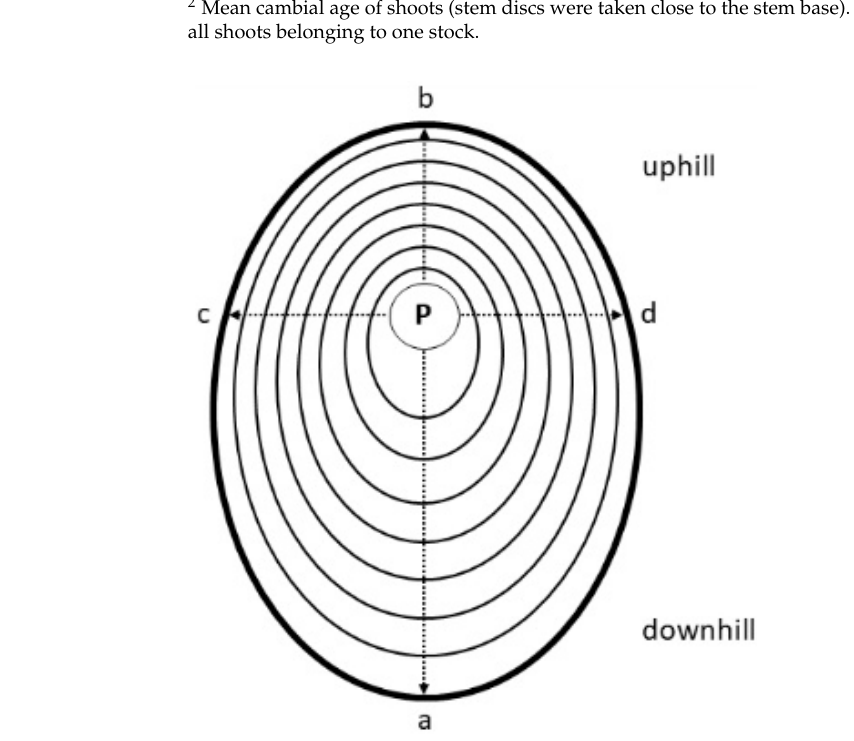
Figure 1. Schematic representation of measured radii. Radii a and b are oriented on the lower and upper side of the stem, respectively. Radii c and d are aligned perpendicular to these radii ( p = pith).